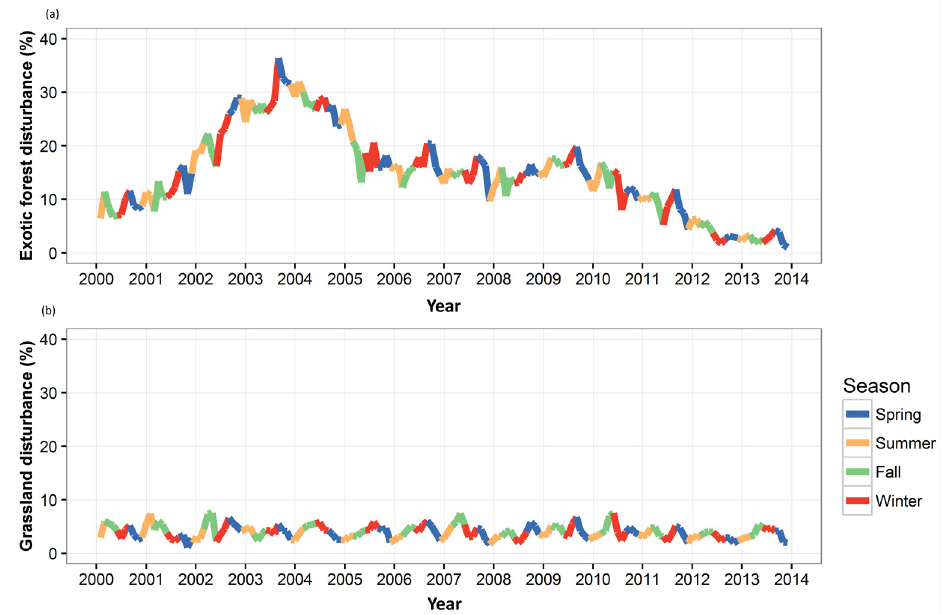
Figure 7. Seasonal variation of disturbance for ( a ) exotic forestry and ( b ) high-producing grasslands. Exotic forestry appears to be significantly more disturbed than grasslands from 2000–2010 and even three times more disturbed than grasslands from 2002–2005.